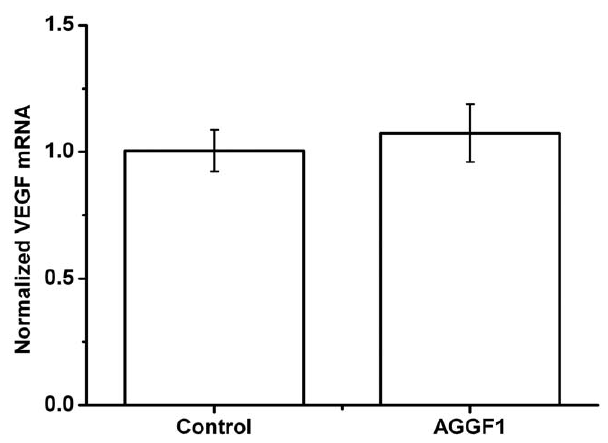
Figure 6. Overexpression of human AGGF1 in a mouse hindlimb ischemia model does not affect the expression level of VEGF . Seven days after delivery of AGGF1 expression plasmid DNA (empty vector as control), mice were sacrificed and gastrocnemius muscle tissues were excised and used for isolation of total RNA and follow-up real time RT-PCR analysis of the mouse VEGF gene. Note that VEGF expression did not show any difference between AGGF1 and control ( P .